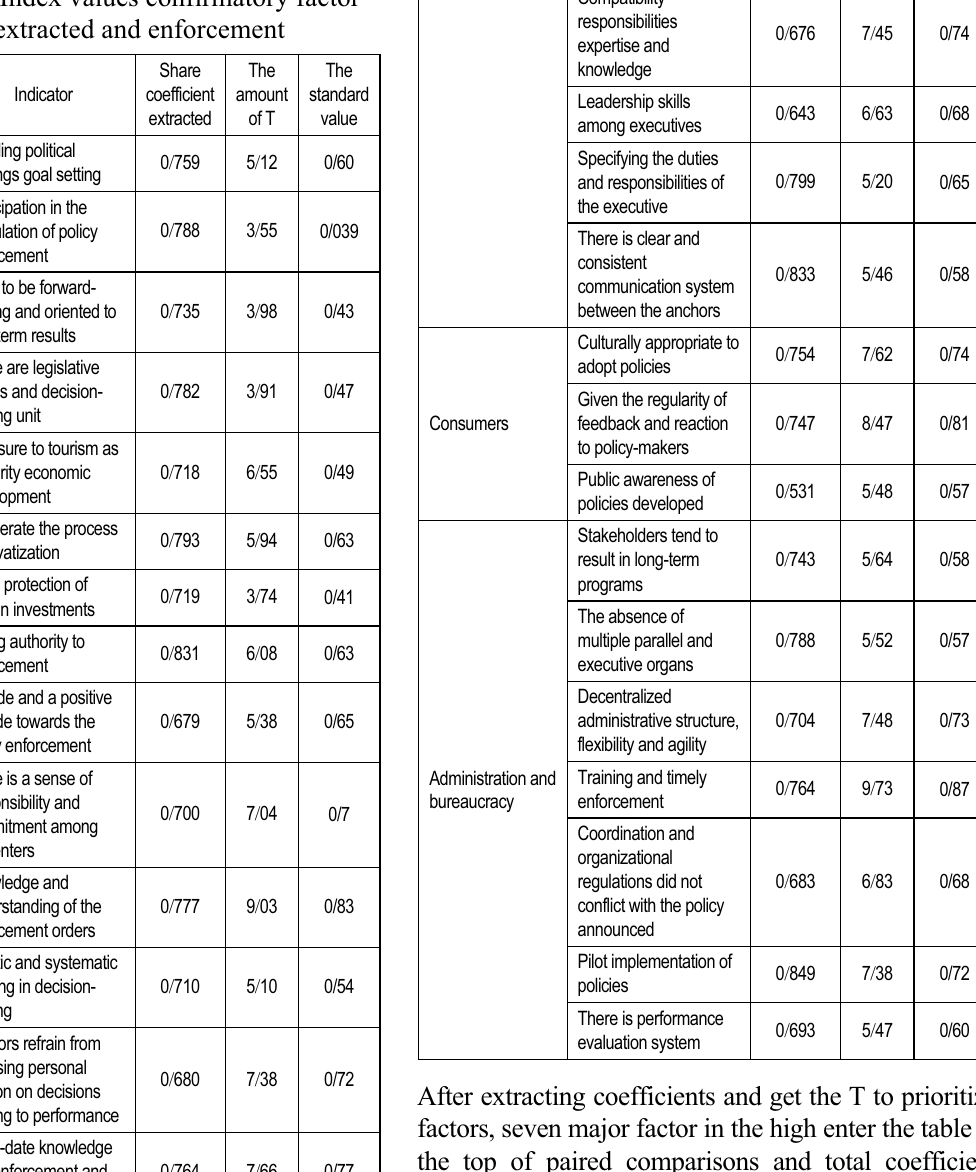
matrix of paired comparisons are as shown in Table 3: Table 3. Matrix of paired comparisons for each indicator